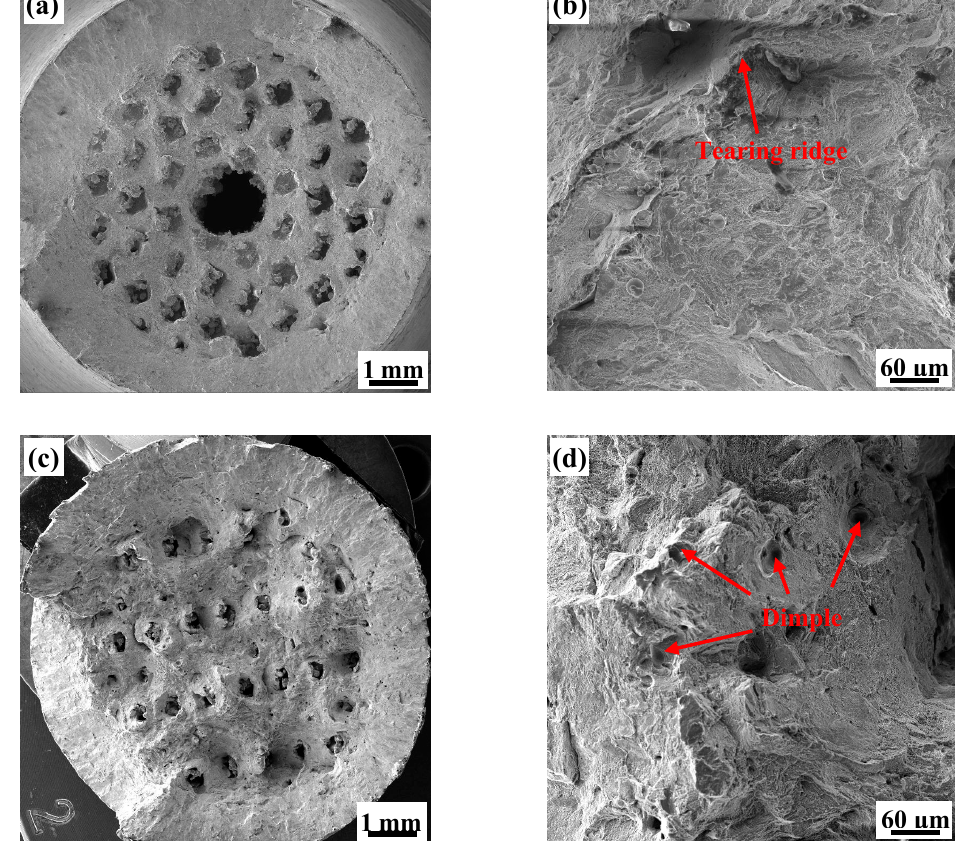
Figure 12. SEM images of: ( a ) the complete fracture morphology of 5H; ( b ) the local fracture micromorphology at high-magnification of 5H; ( c ) the complete fracture morphology of 7H; and ( d ) the local fracture micromorphology at high-magnification of 7H.